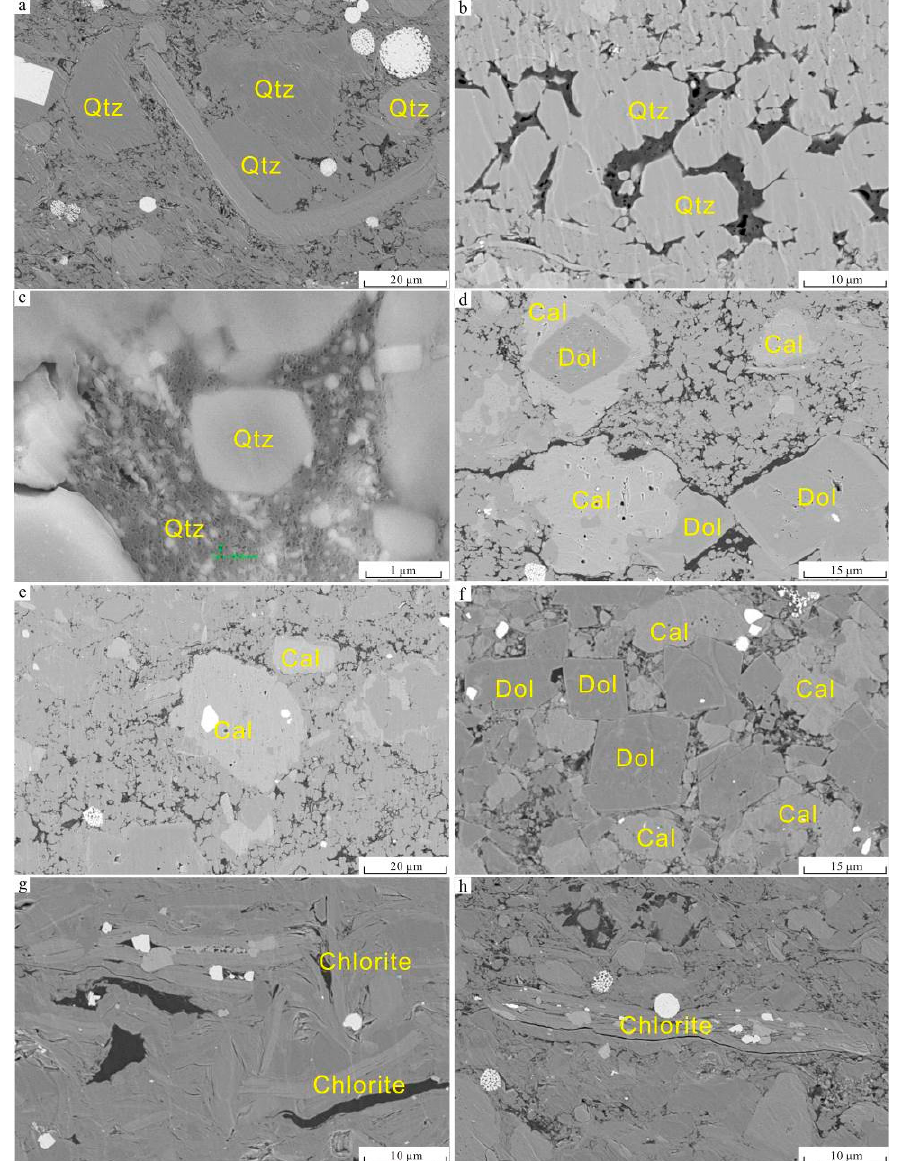
Figure 4. SEM photos showing the occurrence of typical minerals of the Wufeng–Longmaxi shale on the Yangtze Platform, South China. ( a ) Silt-sized quartz, well N211, 2334.17 m; ( b ) microcrystalline quartz, well YH3–8, 3783.4 m; ( c ) quartz associated with clay minerals; ( d ) calcite and dolomite, dissolution pores can be observed on the calcite surface, well YH3–8, 3784.49 m; ( e ) calcite, dissolution pores can be observed on the surface, well YH3–8, 3783.4 m; ( f ) calcite and dolomite, dissolution pores and crushing lines can be observed on the calcite surface, well YH3–8, 3783.4 m; ( g ) chlorite, well N211, 2321.05 m; ( h ) chlorite, well N211, 2334.17 m. Qtz: Quartz, Cal: Calcite, Dol: Dolomite.